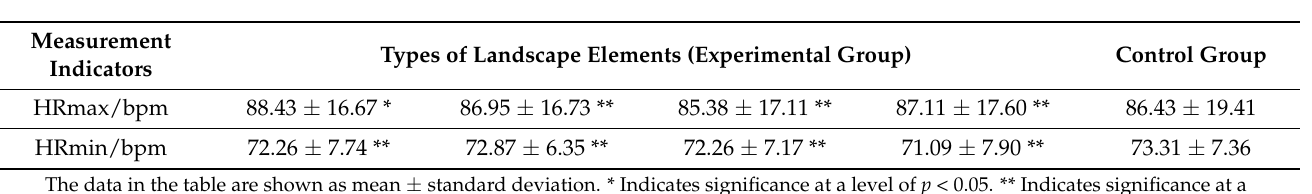
Table 14. Physiological indicators of participants before and after measurement in response to different landscape seating spaces.